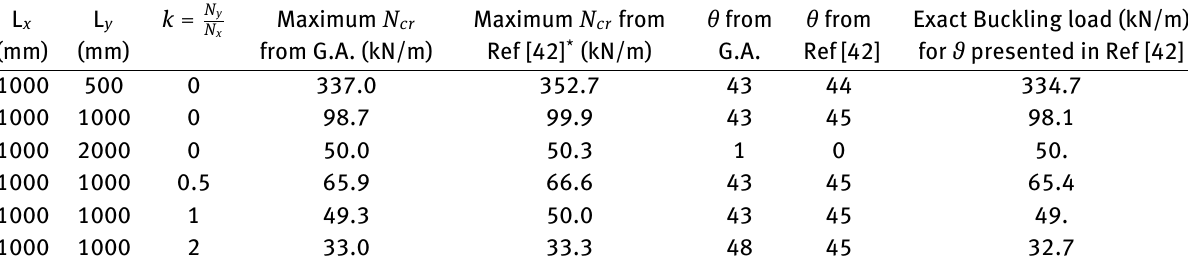
Table 3: Comparison of the optimisation results for a composite sandwich plate.